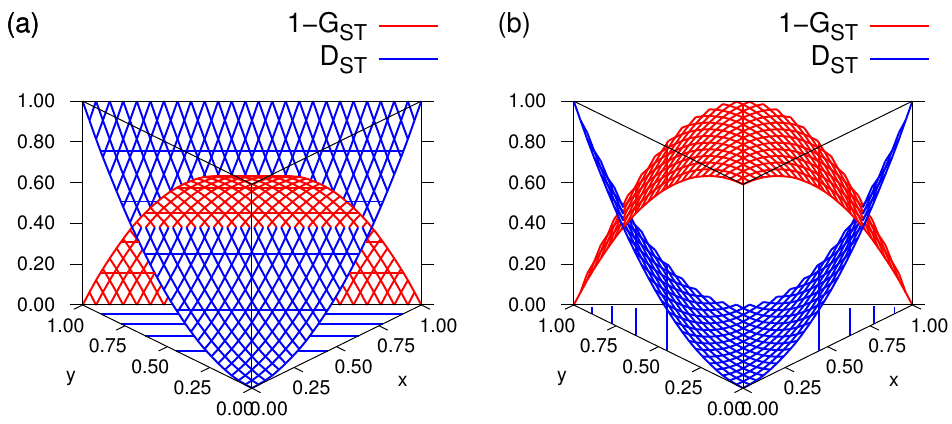
Figure 2. Effect of assignment mappings on type variation within and among two communities: Joint type–community distributions for two equally sized communities and two equally frequent types but differing assignment mappings are modeled as mixtures of tendencies over the triangle: For the same assignment mapping g C ( 1 ) = 1, g C ( 2 ) = 2, plot ( a ) is based on g T ( 1 ) = 1, g T ( 2 ) = 2 and plot ( b ) on g T ( 1 ) = 2, g T ( 2 ) = 1. In both plots, the CC component a ( x = 1) is identical to the CD component b ( y = 1). For both components, the two communities are monomorphic (full concentration) and share no type (full division). In ( a ), the type variation within the communities, measured by 1 − G ST (red surface), decreases from 1 for neutrality ( x = y = 0) to 0 along the entire back edge of the triangle ( x + y = 1), while the type variation among communities, measured by D ST (blue surface), increases from 0 for x = y = 0 to 1 for x + y = 1. In ( b ), variation within and among are the same as for ( a ) along the two front edges of the triangle ( x = 0 and y = 0), but variation within is now maximal and variation among is minimal along the entire line x = y and all mixtures in between. The blue lines on the base of the triangle are projections of the four contour lines drawn on both surfaces at the coordinates 0.2, 0.4, 0.6, and 0.8 on the vertical